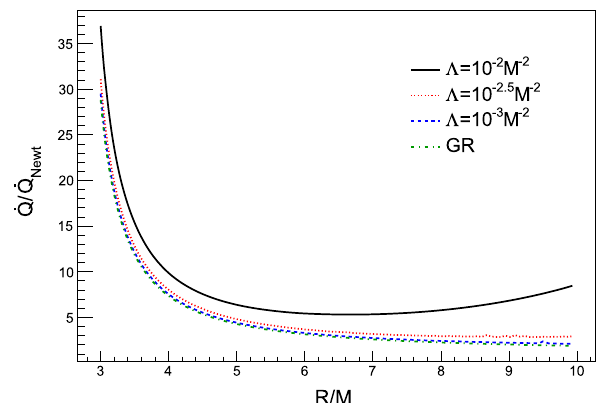
Fig. 5 Ratio of total energy deposition ˙ Q for Λ CMD model to total Newtonian energy deposition ˙ Q Newt for three values of the parameter Λ . The green curve shows the GR energy deposition for